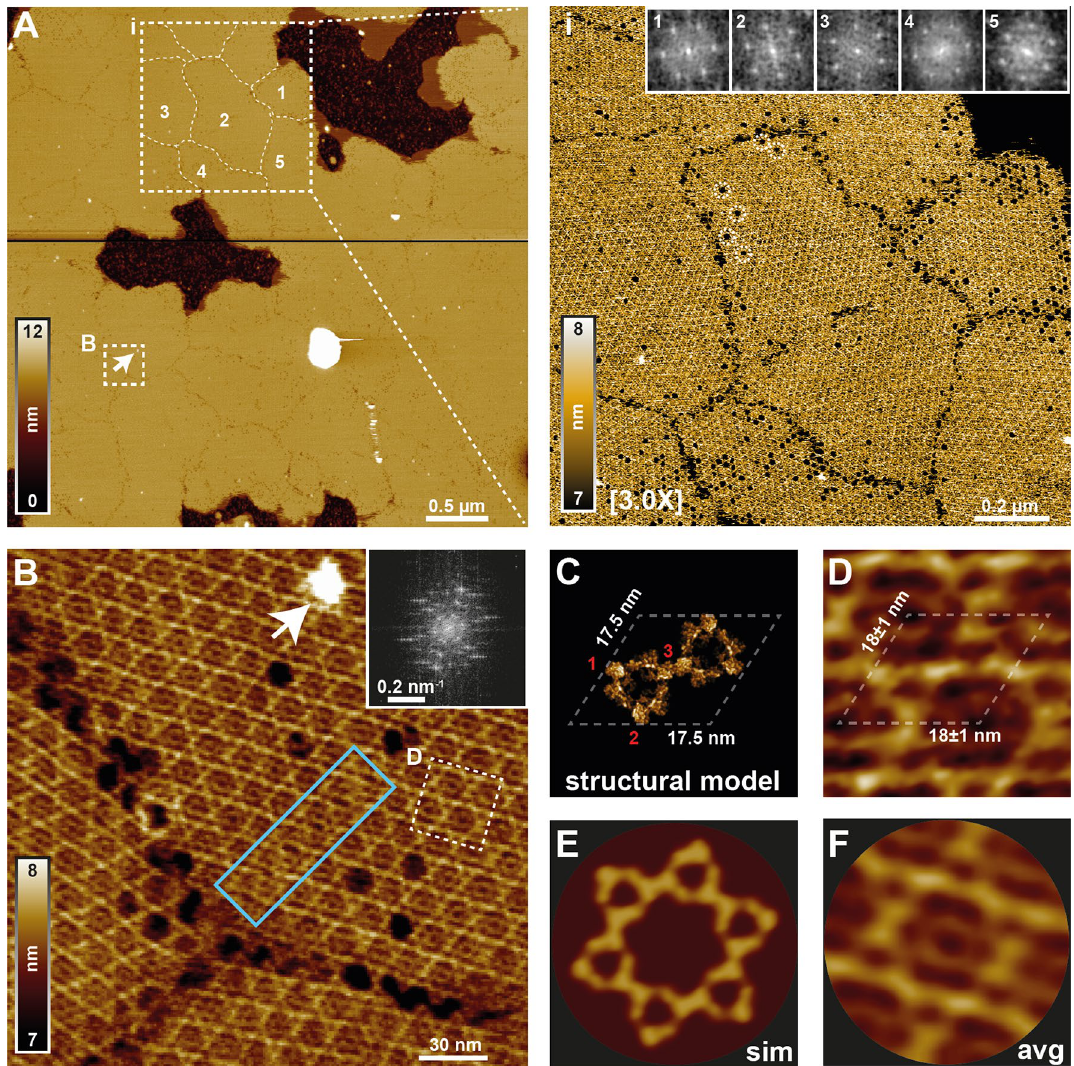
Figure 3. High-resolution imaging of a two-dimensional AnXA5 p6 crystal lattice. ( A ) High-resolution 9 megapixel topography of AnxA5 p6 crystal lattice on a DOPC:DOPS (4:1) membrane bilayer on mica imaged over an area of 4.2 × 4.2 µm 2 at 17 Hz line frequency (3 min/frame). AnxA5 crystalline domains are separated from each other by grain boundaries (dotted outlines within the boxed region labelled ( i ). A 3X enlargement of ( i ) is shown on the right. The grain boundaries delimiting AnxA5 lattices are clearly visible. Insets show the FFT of the lattices domains according to the numbering in the boxed area in ( A ). The six characteristic peaks defining the p6 crystal display different angular rotations, highlighting the different spatial orientation of the lattices. Dashed circles surround vacancies within the lattice. Topography was recorded in buffer solution (20 mM HEPES pH7.4, 150 mM NaCl, 2 mM CaCl 2 ) at room temperature. ( B ) High-resolution topography of the boxed area ( B ) in ( A ) obtained after averaging 30 image frames. The inset shows the FFT of the topography. Crystal defects presenting characteristic zipper-like patterns are indicated by the cyan box. ( C ) Molecular model of the AnxA5 unit cell, formed of two AnxA5 trimers. ( D ) Close-in of the boxed region shown in ( B ), emphasizing the high quality of the image. The two AnxA5 trimers and the protomers forming each trimer as numbered in ( C ) are clearly resolved. The ~ 18 nm unit cell is indicated by dashed lines. ( E ) Simulated AFM image of the molecular model for the AnxA5 hexagonal lattice (see “Methods” section). ( F ) Correlation- averaged image of the AnxA5 p6 assembly imaged in ( B ). Individual ( A , B , D , F ) were generated using ImageJ 1.52e (https:// imagej. nih. gov/ ij/ index. html) and/or Matlab 2020b (https:// it. mathw orks. com/ produ cts/ matlab. html). Structural model in ( C ) and pseudo AFM graphics in ( E ) were generated using PyMOL 2.4.1 (https:// pymol. org/2/) and BioAFMviewer 1.1 (http:// www. bioaf mview er. com/), respectively. Final figure was assembled, edited, and rendered with Adobe Creative Cloud suite (https:// www. adobe. com/ creat ivecl oud.